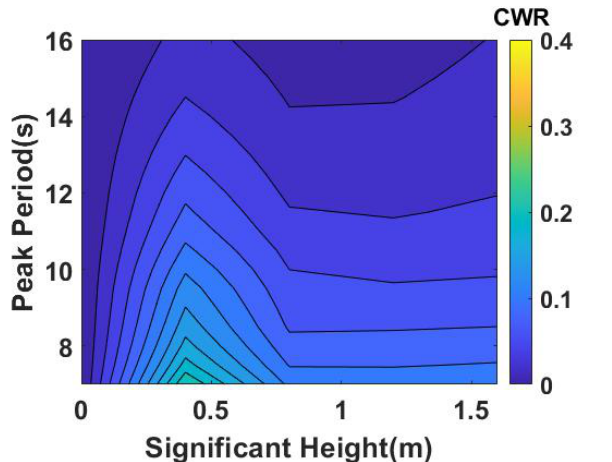
Fig. 12: The power extraction of different waves with a low control limitation.